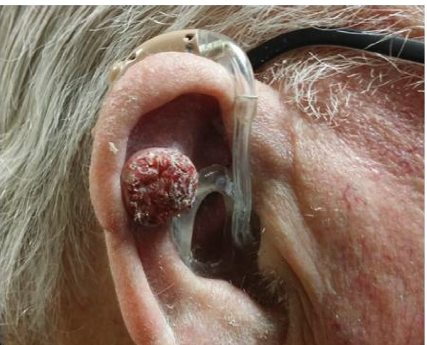
Figure 5: Clinical photograph showing the right pinna with a one-centimetre raised, ulcerative, crusted lesion at the upper margin of the previous incision